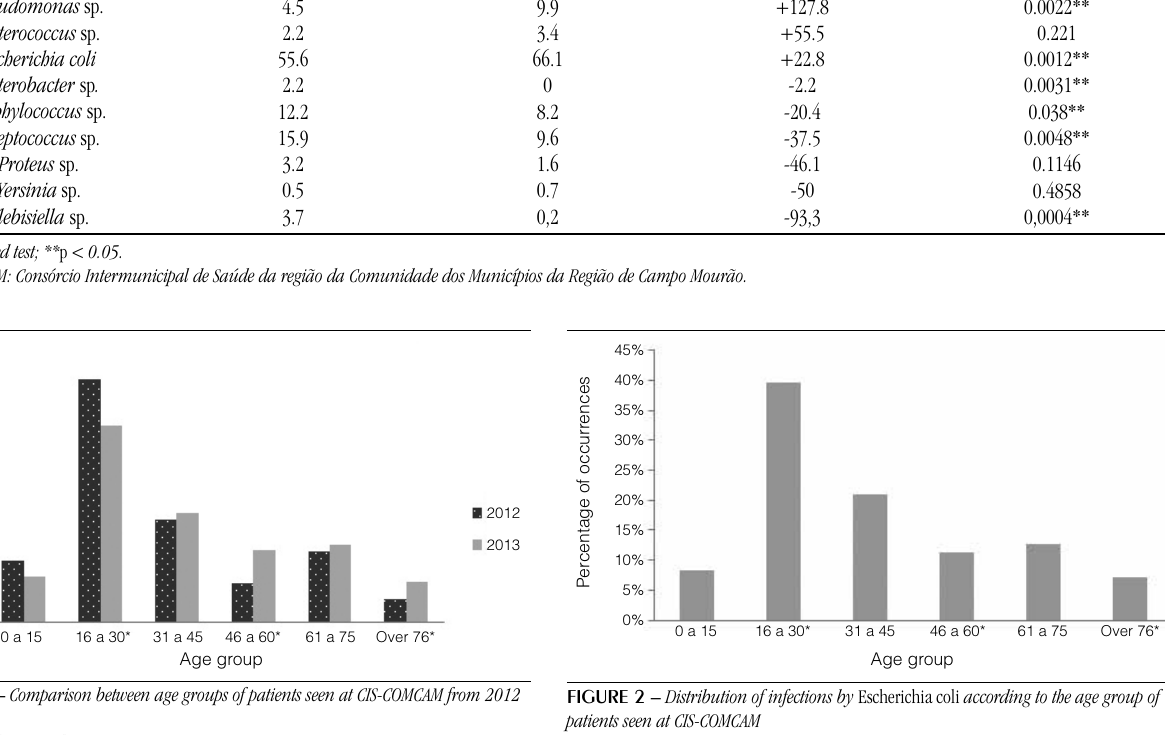
tABLE 1 – Prevalence and variation of microorganisms isolated from the urine of patients seen at CIS-COMCAM between 2012 and 2013 Bacterium 2012 (%) 2013 (%) % of variation p value* Pseudomonas sp.